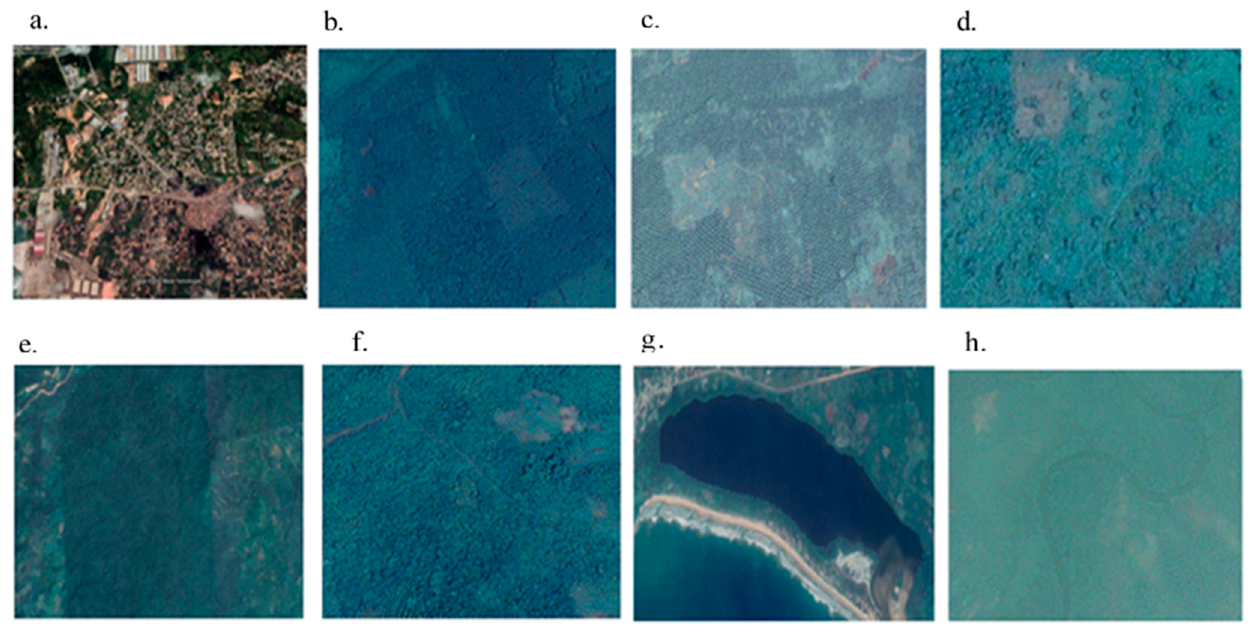
Figure 3. Screenshots of land cover types used in the classification (clipped from google earth image, date: January 2020), ( a ) settlement, ( b ) rubber, ( c ) palm, ( d ) cropland, ( e ) forest, ( f ) shrubland, ( g ) waterbody, ( h ) wetland.